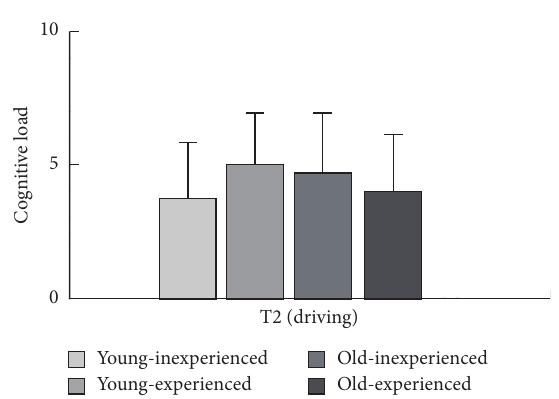
Figure 5: Cognitive load of interaction of age and experience. Table 2: Descriptive statistics of frequency and percentage of interaction errors among different